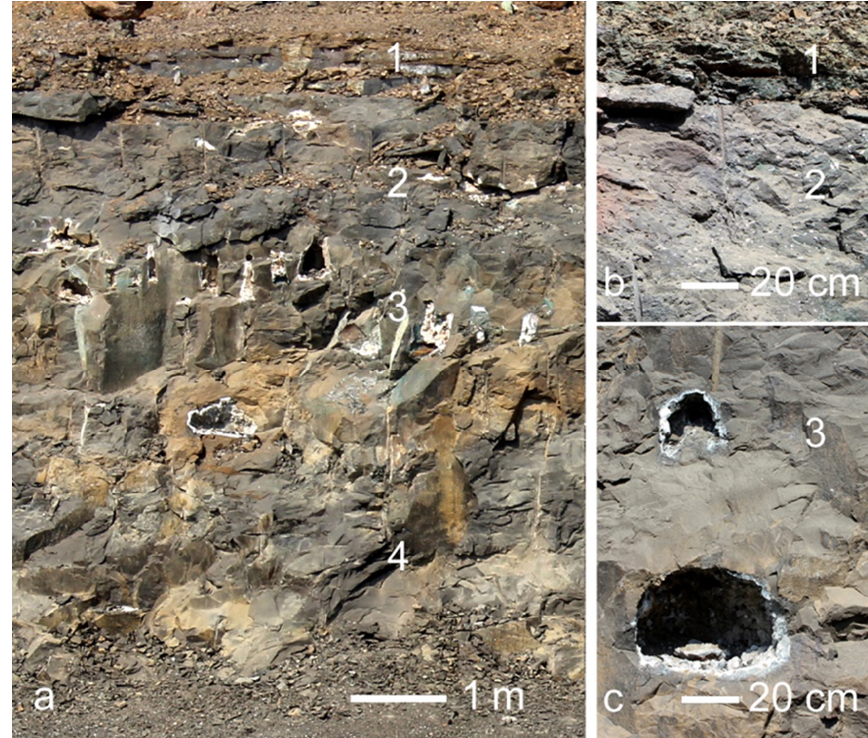
Figure 3. ( a ) Quarry wall (7 m high) displaying different zones: (1) bole; (2) intensely altered upper zone with large number of small vesicles, partly filled with secondary minerals; (3) dense flow core zone with large cavities; (4) bottom zone with a low number of vesicles. ( b ) Detail of an upper zone of a flow with (1) intensely weathered green bole; (2) intensely altered upper zone with high number of small vesicles, partly filled with secondary minerals. ( c ) Detail of the flow core zone showing dense host rock (3) with large mineral-lined cavities.